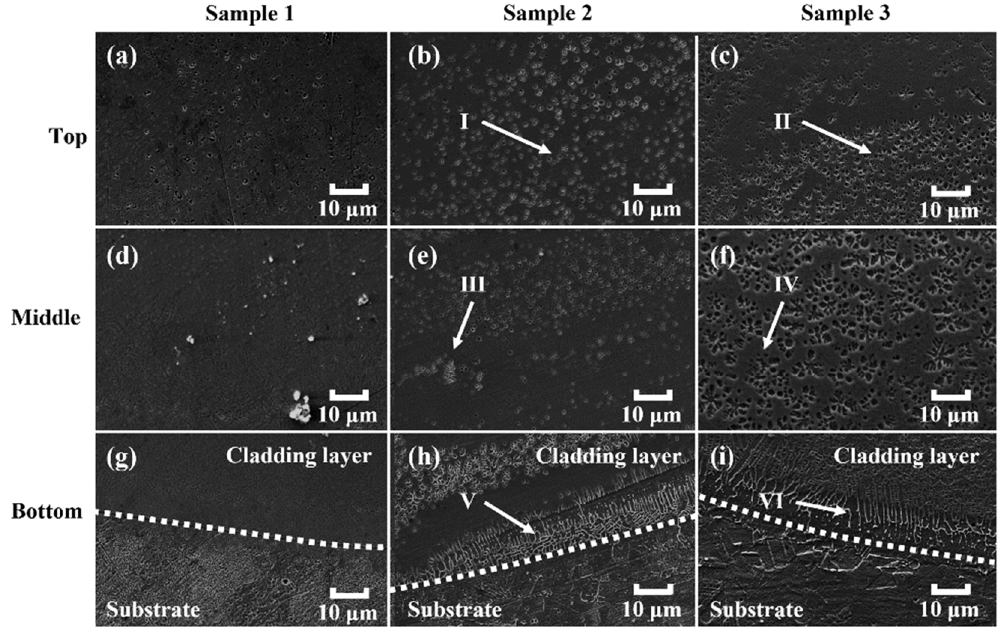
Figure 8: SEM photographs of microstructure in di ff erent parts of di ff erent samples. ( a – c ) Top, ( d – f ) middle, and ( g – i ) bottom. ( a, d, and g ) Sample 1, ( b, e, and h ) sample 2, and ( c, f, and i ) sample